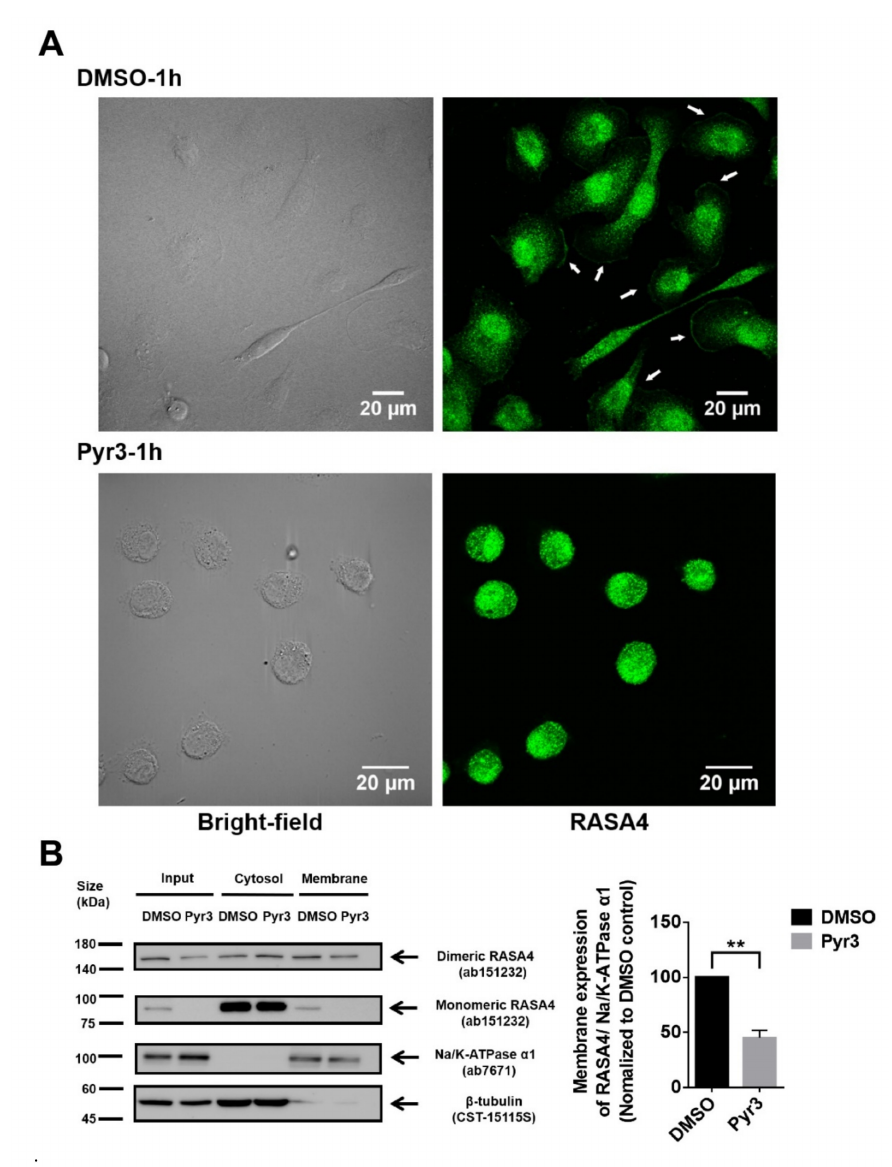
Figure 5. Blocking TRPC3 in MDA-MB-231 downregulated RASA4 expression on the plasma membrane. ( A ) representative confocal images showing the subcellular distribution of RASA4 (green) in MDA-MB-231. Cells were fixed after DMSO / Pyr3 treatment for 1 h. Merging fluorescence image with bright field image suggested that RASA4 expression on the plasma membrane (indicated by white arrows) was decreased in most of the Pyr3-treated cells. Scale bar: 20 µ m; ( B ) subcellular fractionation followed by Western blot analysis confirmed that blocking TRPC3 by Pyr3 (1.0 µ M for 1 h) significantly decreased the expression of RASA4 proteins in the membrane fraction of MDA-MB-231 when compared to DMSO control group. Na / K-ATPase α 1 was used as a membrane protein marker and β -tubulin was used as a cytosolic protein marker. Band density (total RASA4 normalized to Na / K-ATPase α 1) was calculated by Image J software. Values are mean ± SEM ( n = 3). ** p <